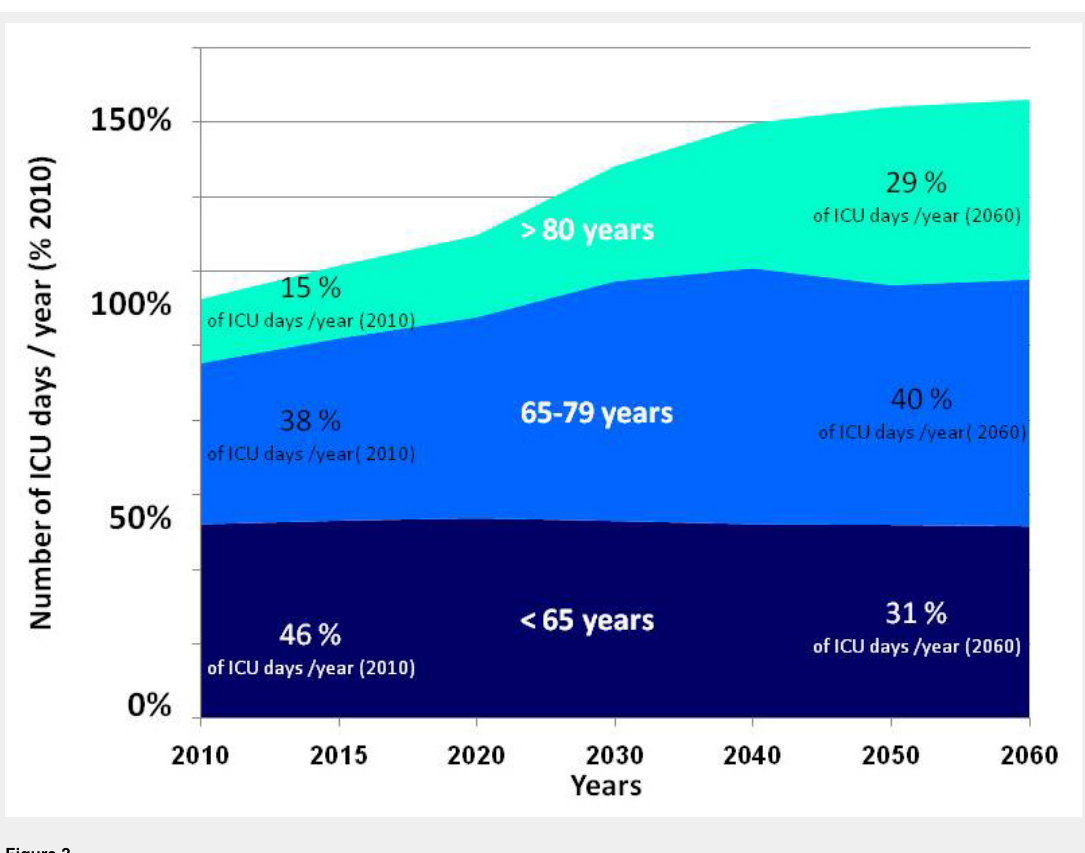
Figure 2 Evolution of the resource consumption (ICU days) in Switzerland over the next 50 years, depending on the age categories. The figure shows the evolution of the total number of ICU patient-days (expressed as the percentage of the resource consumption of 2010) needed per year from 2010 to 2060 for younger patients (aged less than 65 years), for the elderly (65–79 years) and for very elderly (>80 years) ICU patients (source of data: Bundesamt für Statistik [19]).